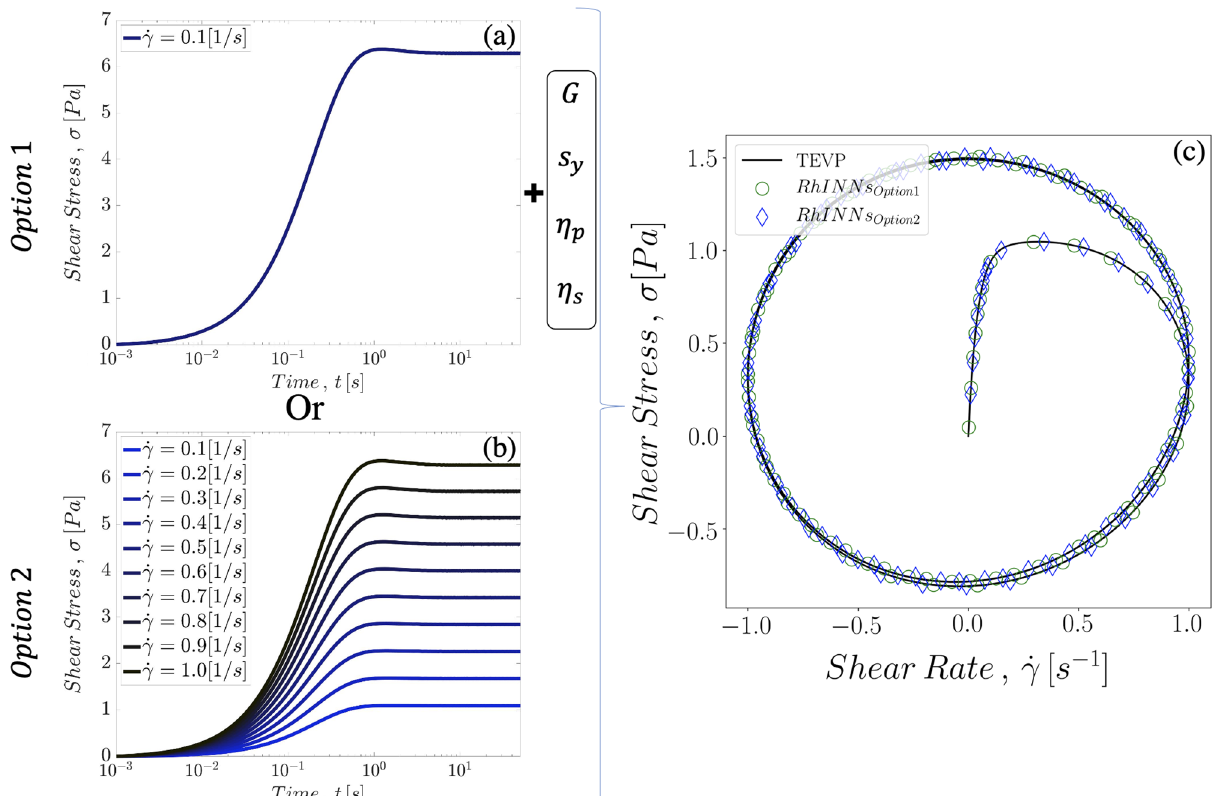
Figure 8. Combination of data driven discovery and data driven solution methodologies. First option provides the elastoviscopalstic properties and the results of a simple shear rate experiment, and the second option is only informed by ten different flow curves at constant shear rates without any prior knowledge of material parameters. In both options, these information are utilized to learn the hidden rheology, and subsequently predict the stress response of the TEVP fluid to a LAOS